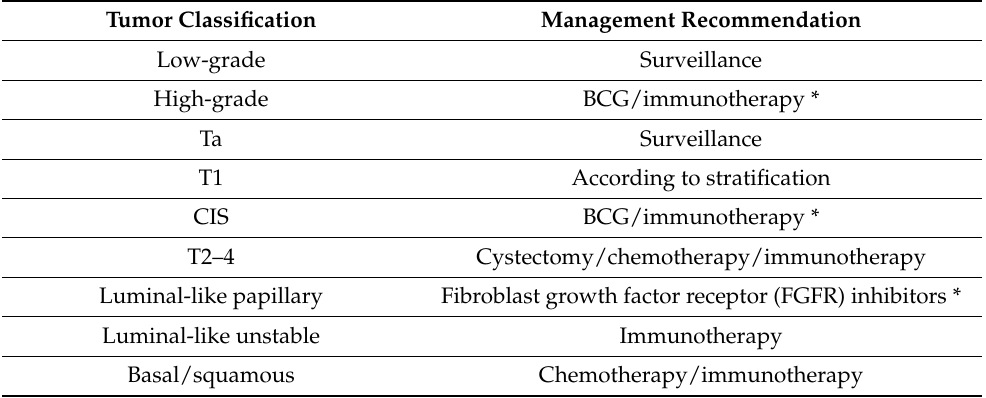
Table 2. Histological classification of bladder cancer and therapeutic